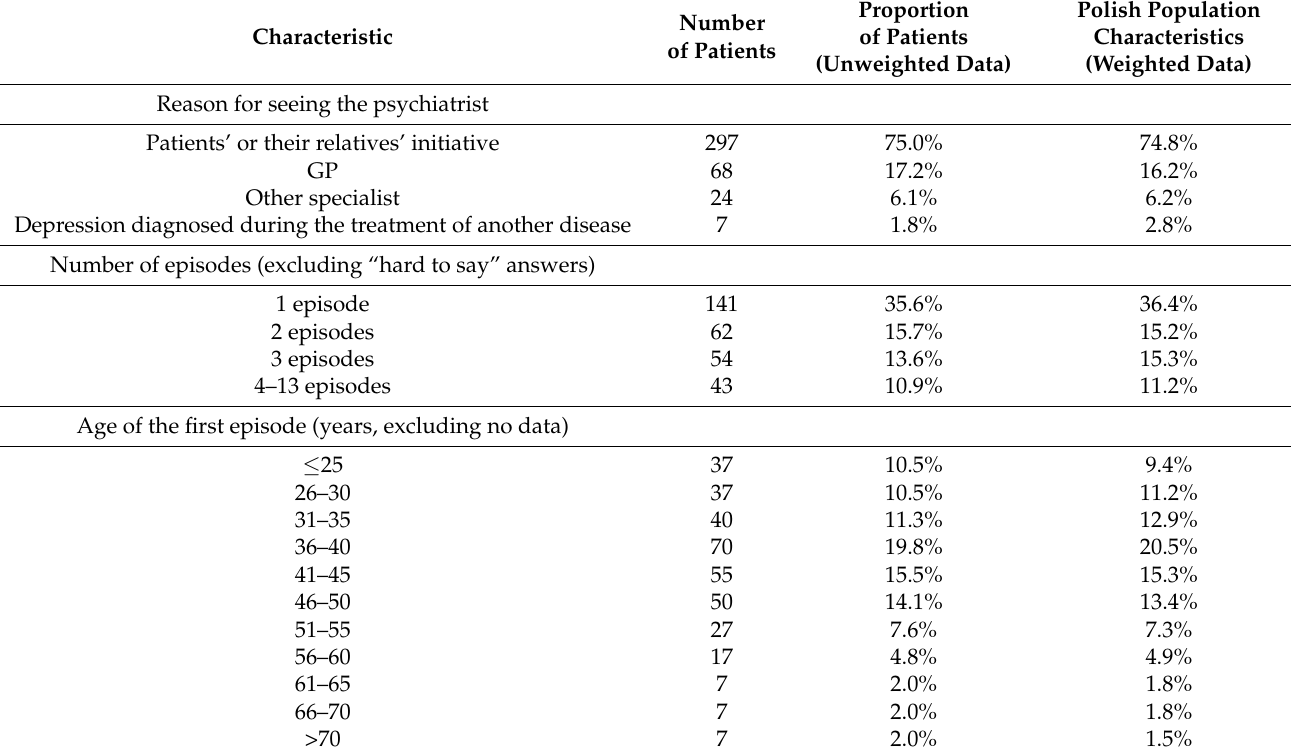
Table 2. Medical characteristics of TRD patients included in the